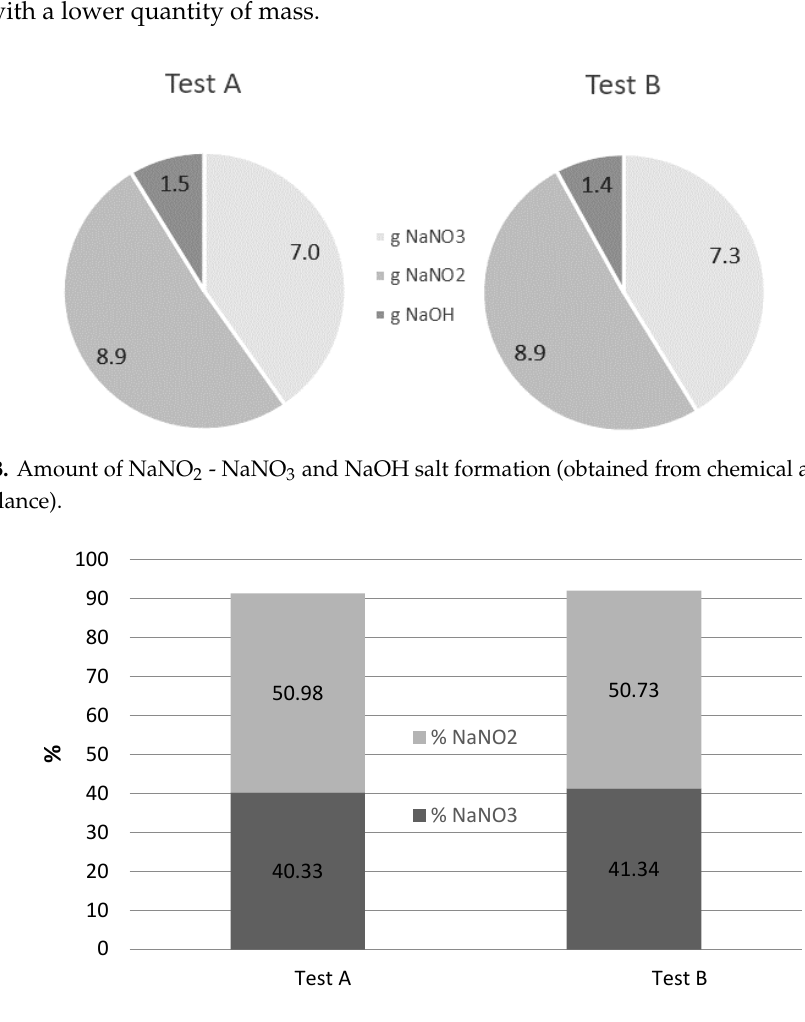
Figure 9. Percentages of NaNO 2 - NaNO 3 and NaOH salt formed.